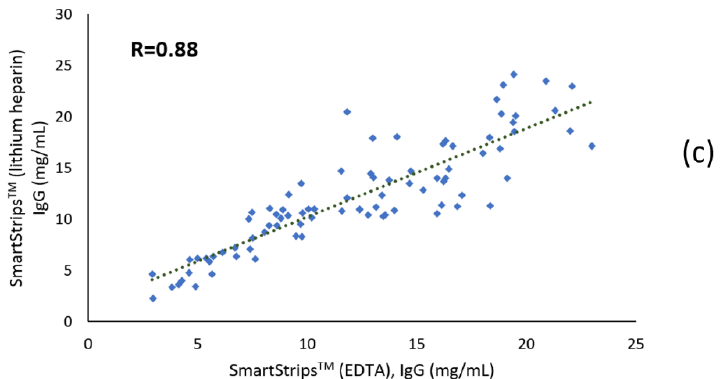
Figure 2. ( a ) Serum IgG concentration determined by ELISA, compared with %Brix of calf serum ( n = 97); ( b ) Serum IgG concentration determined by ELISA, compared with serum IgG concentration determined by the quick test (SmartStrips TM ) with EDTA or lithium heparin anticoagulants ( n = 91 and 87, respectively) ( c ) Serum IgG concentration determined by the SmartStrips TM with lithium heparin anticoagulant, compared with serum IgG concentration determined by the SmartStrips TM with EDTA anticoagulant ( n = 86).